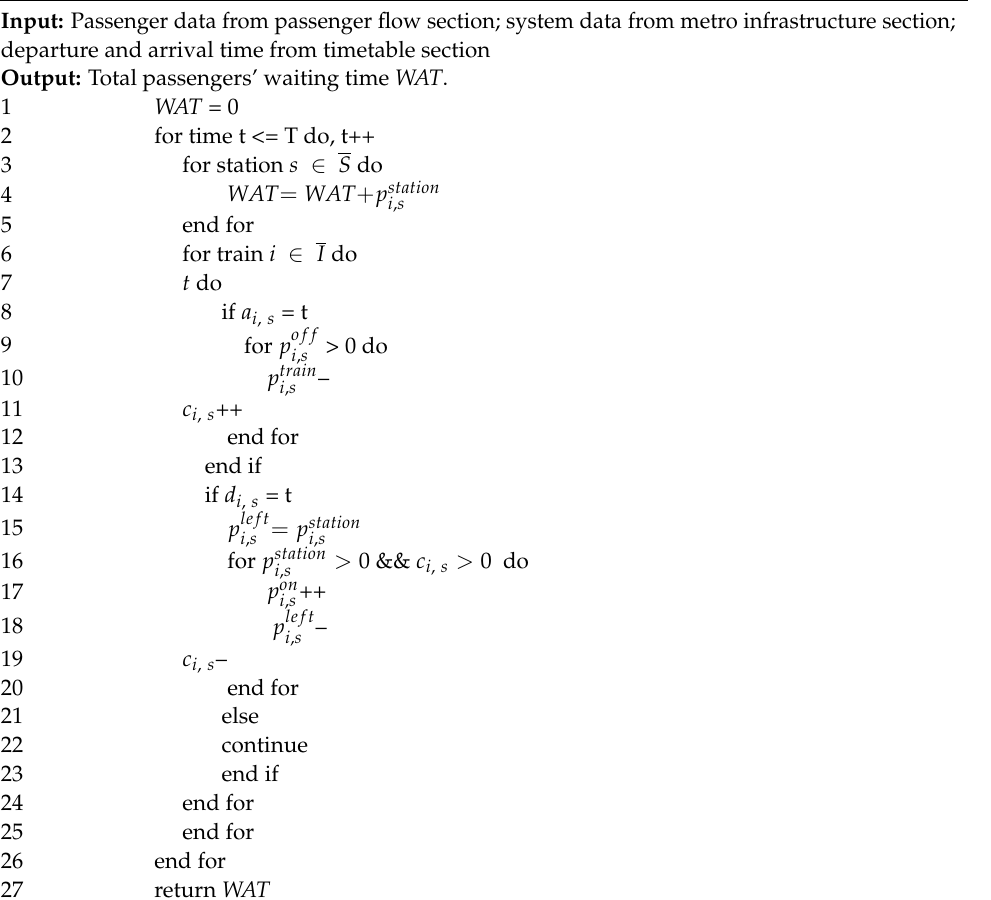
Algorithm 2: Passenger–train interaction